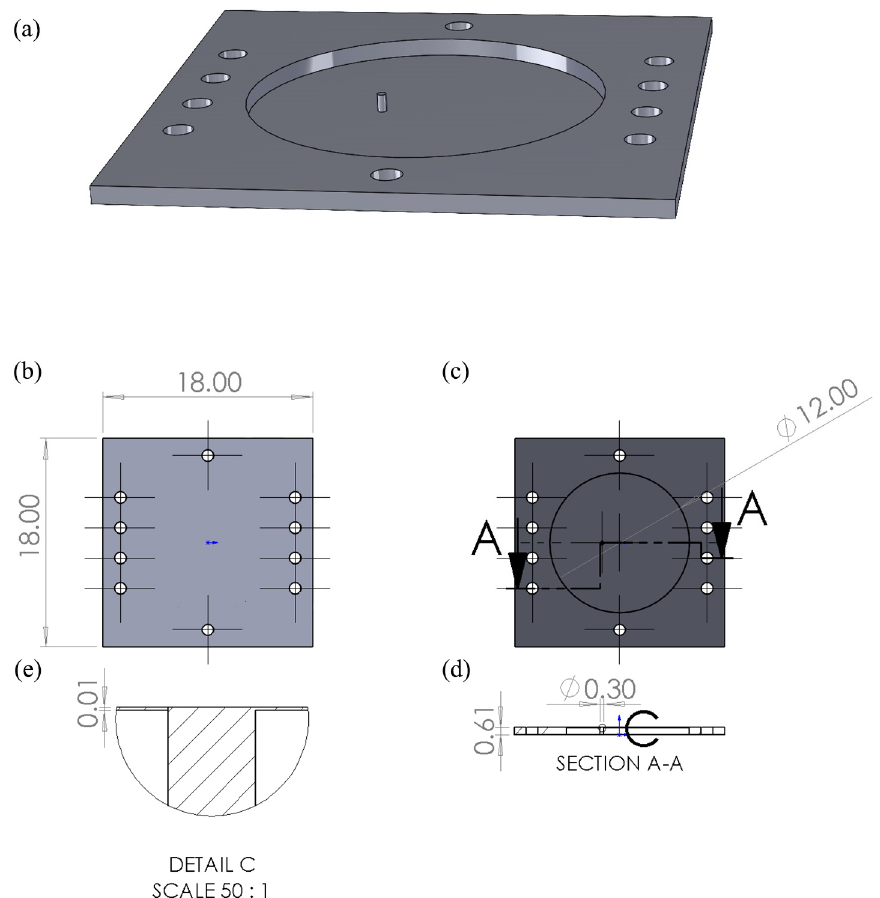
Figure 4. Perspective view and scale drawings of the test structure used for experimental validation. ( a ) An SOI waver was processed using lithography, DRIE etching, and wet etching to produce a square structure with a 12 mm diameter circular face sheet containing one off-center post. Alignment holes were etched into the square frame to help with subsequent magnet assembly. ( b ) Top-view scale drawing of the 18 mm square test structure. ( c ) Bottom-view scale drawing of the test structure. ( d ) Sectional view showing cross-section of the post. ( e ) Detailed enlargement of the post connection to the face sheet. Not shown is the 1 µ m thick oxide layer between the post and the face sheet.